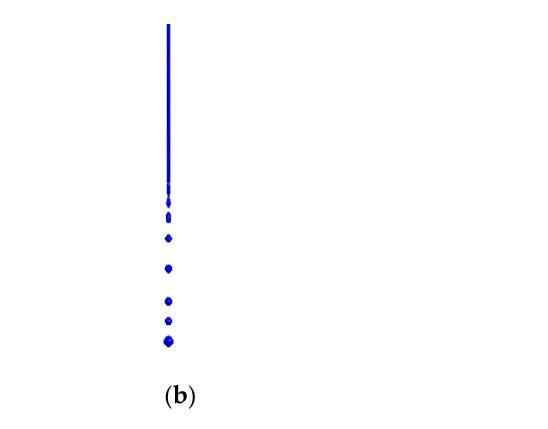
Figure 11. Comparison of the CFD model predicted breakup process of a molten slag ligament under centrifugal force and that of a water ligament under gravity. ( a ): Molten slag ligament breakup; ( b ): Water ligament breakup.